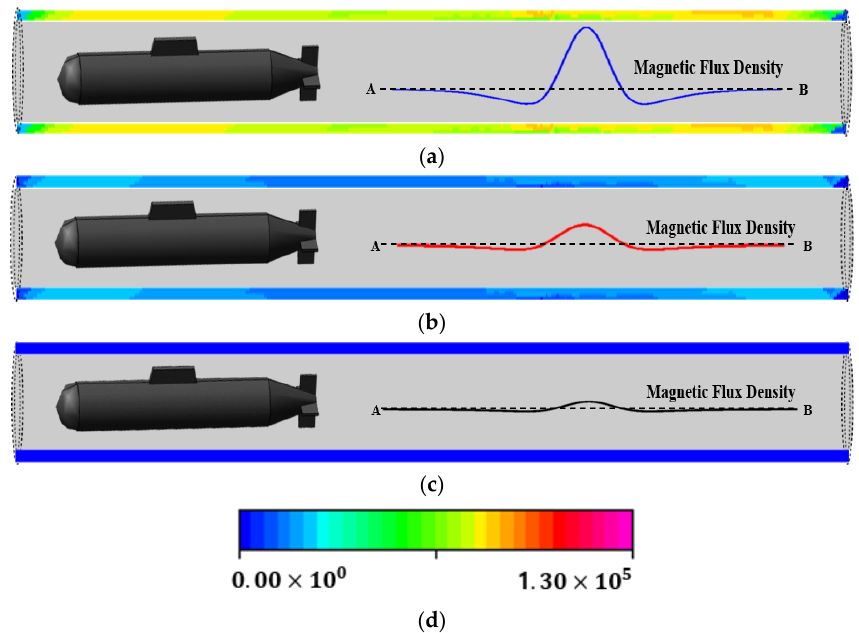
Figure 11. Simulated distribution of the residual magnetization according to the protocols: ( a ) An- hysteretic Deperm; ( b ) Deperm-ME; ( c ) proposed protocol; ( d ) contour bar.